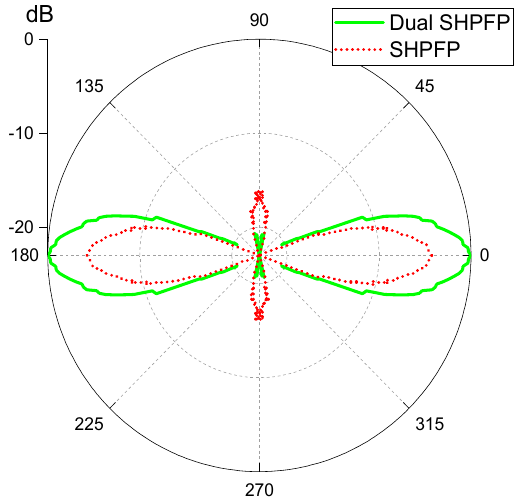
Figure 19. Polar diagrams showing the SH0 amplitude (blue lines) together with the S0 Lamb wave amplitude (orange lines) of ( a ) the dual SHPFP and ( b ) the original SHPFP.